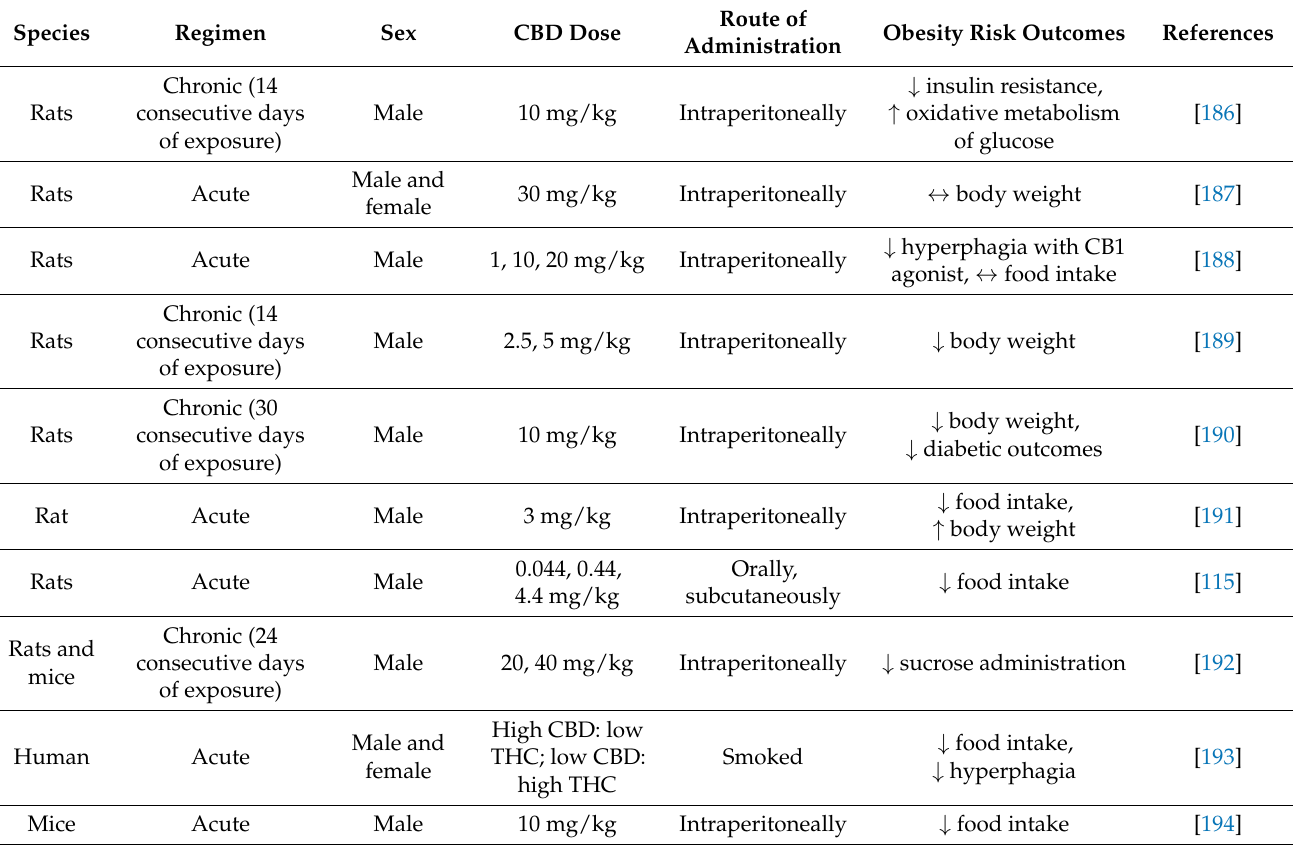
Table 4. An analysis of both preclinical and clinical trials that represent CBD administration and the primary outcome it had on inducing obesity-related symptoms. It should be noted that the majority of papers were based on the adult demographic, with the exception of the first two references, which were based on adolescent and prenatal age groups,